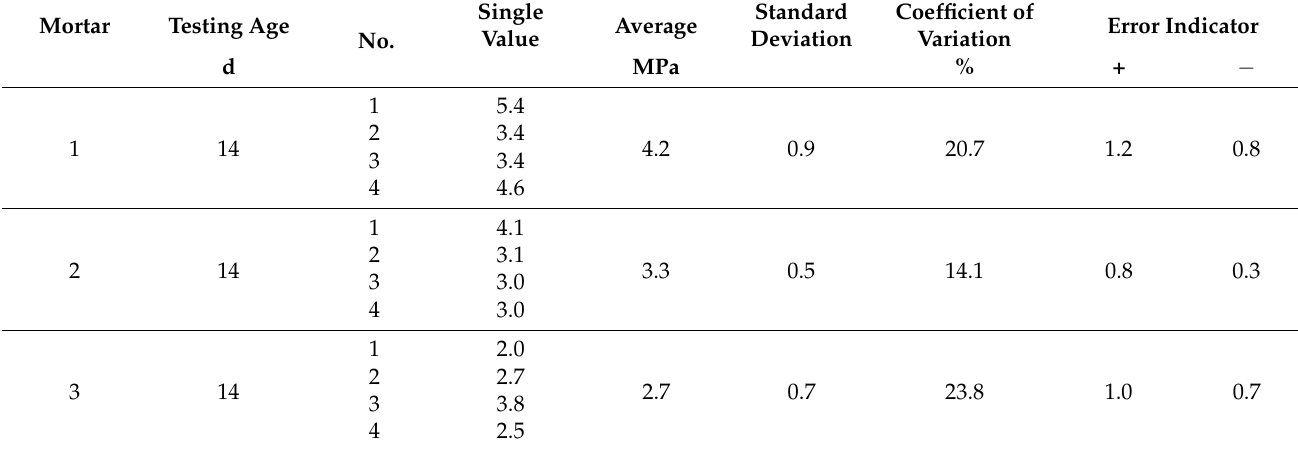
Table A4. Initial crack mortar stress, uniaxial tension test, glass textile, Mortar